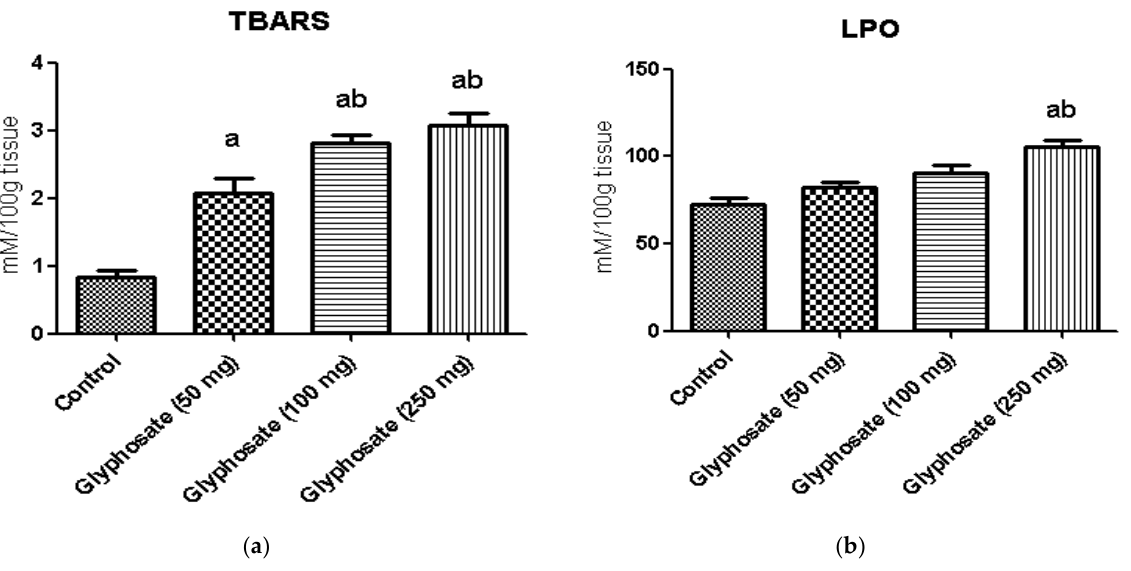
Figure 2. ( a , b ): The effect of glyphosate on oxidative stress markers (TBARS and LPO) in control and glyphosate treated rats. Data were expressed as mean ± SEM where n = 6 rats for each group. Values significant at p < 0.05 were analyzed with a — control, b — glyphosate (50 mg/kg b.wt.).